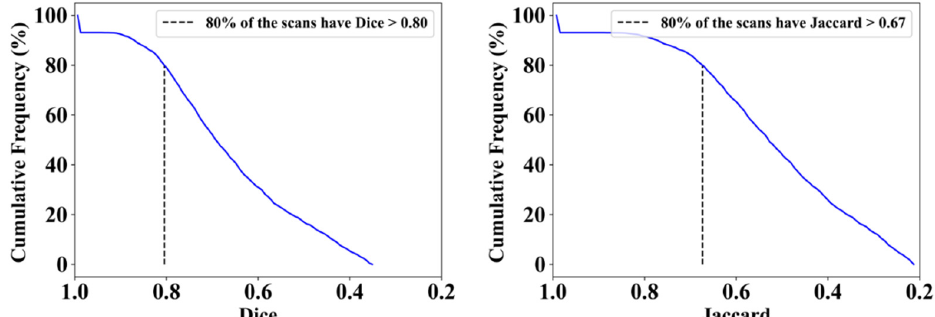
Figure 15. Cumulative frequency plot for Dice ( left ) and Jaccard ( right ) for VGG-UNet when com- puted against MD 1.